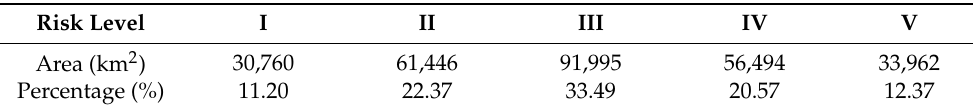
Figure 5. Spatial distribution of nonpoint source pollution risk. Table 3. Risk level